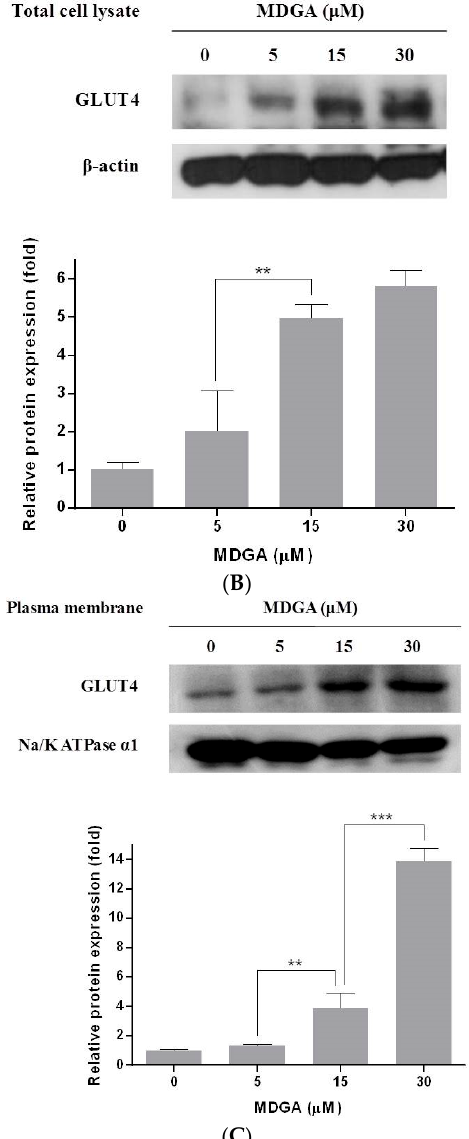
Figure 3. Enhancing effect of MDGA on glucose uptake in adipocytes. 3T3-L1 preadipocytes were stimulated with a mixture of adipogenic inducers containing 0.1 μ g/mL insulin, 0.5 mM IBMX, and 1 μ M dexamethasone. Cells were simultaneously treated with MDGA (0, 5, 15, or 30 μ M) every other day during the first 4 days of differentiation. ( A ) On day 6, the adipocytes were incubated in DMEM containing 0.2% BSA for 4 h, and then glucose uptake was measured. Cells were harvested at day 6, and ( B ) whole cell lysates or ( C ) plasma membrane fractions were subjected to Western blot analysis for GLUT4, and the protein expression levels were normalized against β -actin or Na/K ATPase α 1, respectively. The intensity of each band was quantified by the WCIF Image J for Window Program. All values are presented as the mean ± SD of three experiments performed in triplicate. Statistical significance: * p < 0.05, ** p < 0.01, *** p < 0.001.